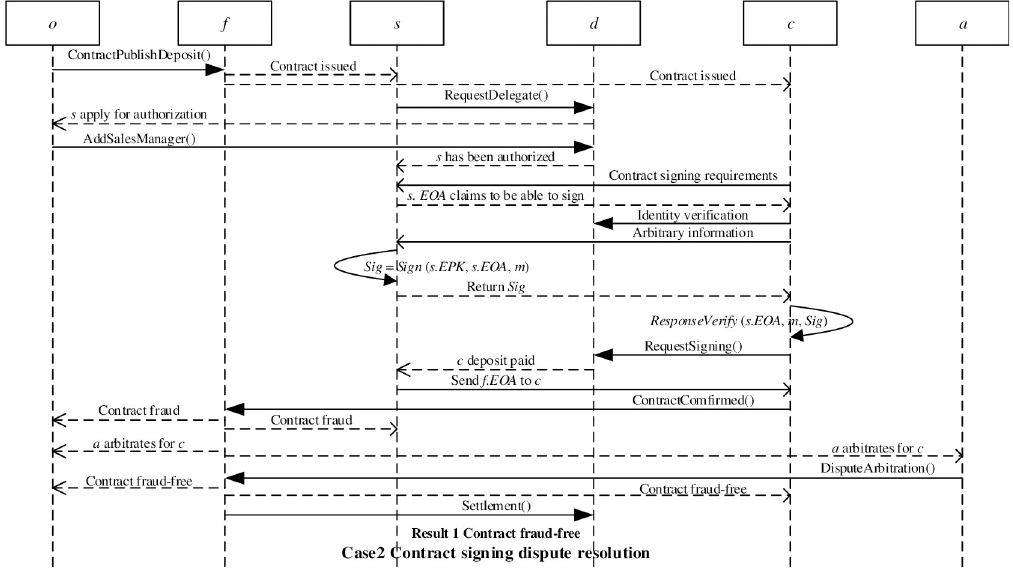
Fig 6. Contract fraud-free dispute